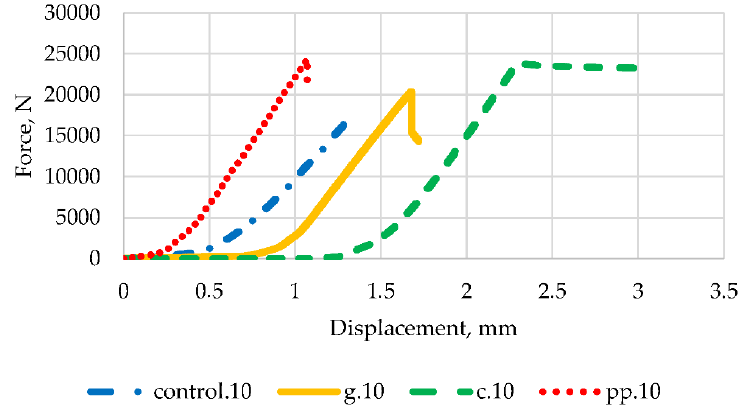
Figure 15. Load vs. displacement curves for 10 ◦ angle and all types of mortar.